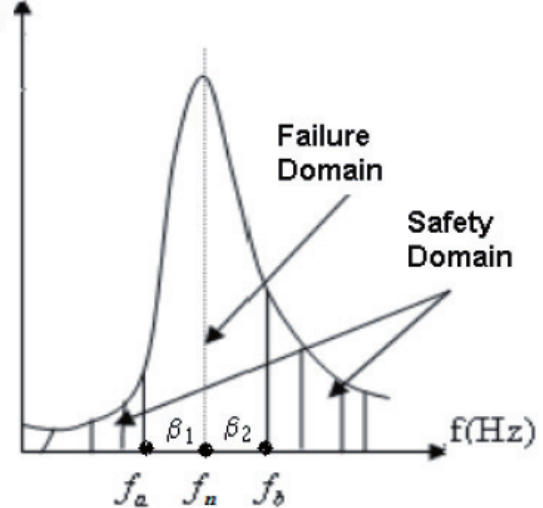
Fig. 4. The safest point at frequency fn